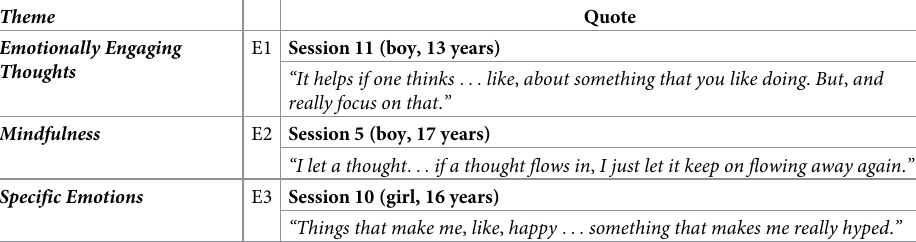
Table 3. Quotes on emotional regulation strategies during slow cortical potential training.